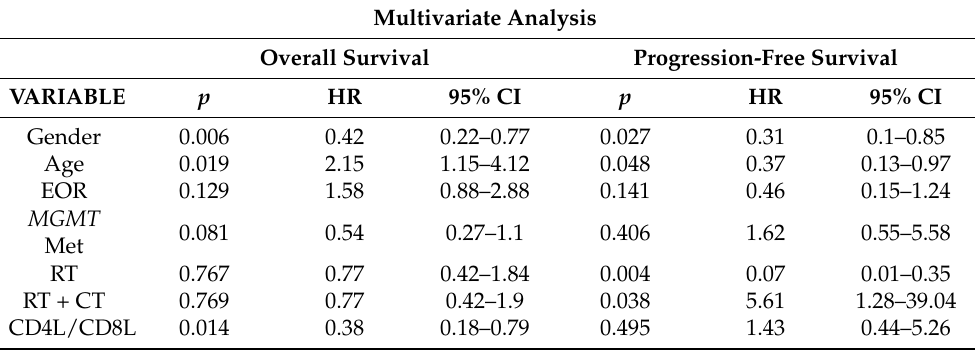
Table 3. Cox regression analyses of different parameters for overall survival and progress-free survival. EOR: extent of resection; Met: Methylation; RT: radiotherapy; CT: Chemotherapy. Multivariate Analysis Overall Survival Progression-Free Survival VARIABLE p HR 95% CI p HR 95% CI Gender 0.006